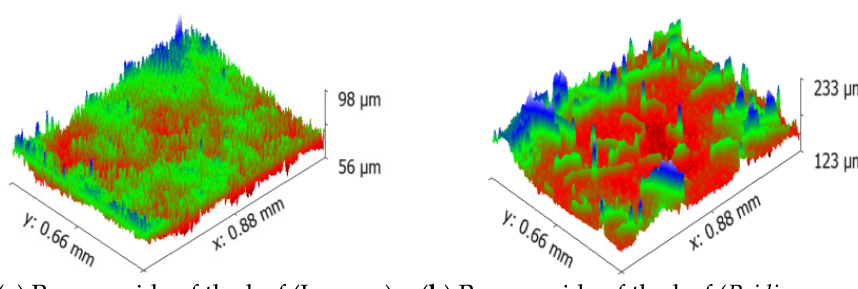
Figure 8. Target leaf surface 3D structures for rough factors in the range of 1.3–1.5. Catalysts 2020 , 10 , x FOR PEER REVIEW